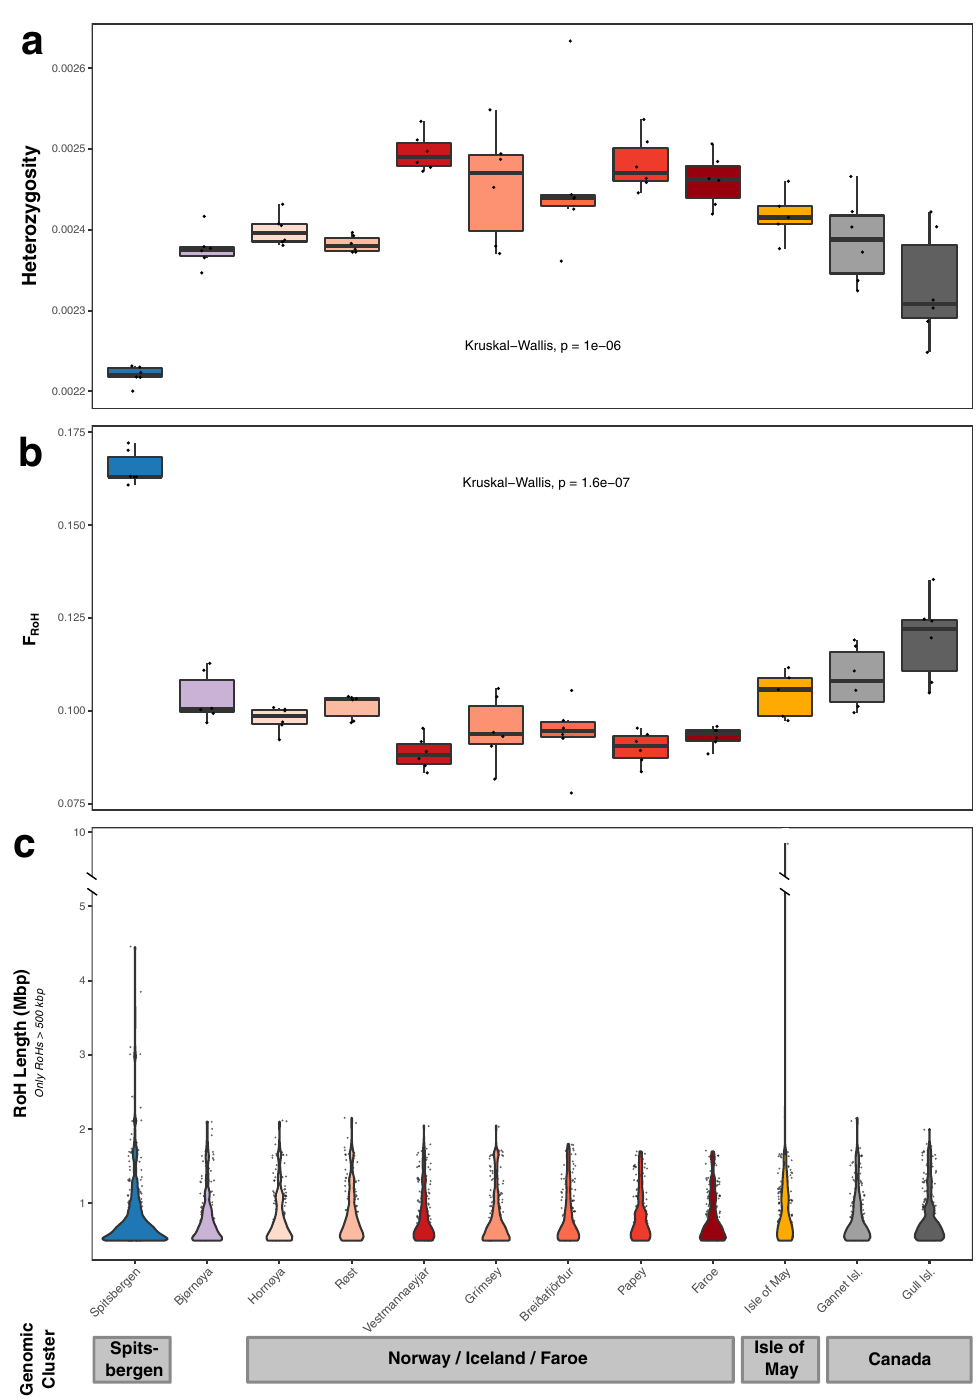
Fig. 3 Genome-wide heterozygosity, inbreeding, and Runs-of-Homozygosity (RoH) compared between 12 Atlantic puf fi n colonies across the species ’ breeding range. a Estimates of individual genome-wide heterozygosity based on the per-sample one-dimensional Site Frequency Spectrum calculated in ANGSD. b Individual inbreeding coef fi cients, F RoH , de fi ned as the fraction of the individual genomes falling into RoHs of a minimum length of 150 kb. RoHs were declared as all regions with at least two subsequent 100 kb windows harboring a heterozygosity below 1.435663 × 10 − 3 . c RoH length distribution across the 12 colonies only including RoHs longer than 500 kb. A single 9.65 Mbp long RoH on pseudo-chromosome 7 in an Isle of May individual required to introduce a break in the y-axis. In ( a ) and ( b ), black dots indicate individual sample estimates and black lines the median per colony, while in ( c ), black dots represent single RoHs. Statistical signi fi cance of differences in heterozygosity and F RoH between populations was assessed with a global Kruskal- Wallis test ( n = 12). The results of post hoc Dunn tests with Holm corrections are presented in Fig. S12. Error bars show range of values within 1.5 times the interquartile range. Different colonies in all three plots are indicated using the same color code as in Fig. 1. The dataset(s) needed to create this fi gure can be found at https://doi.org/10.6084/m9. fi